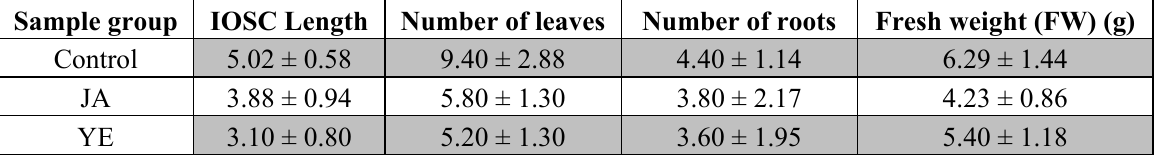
Table 1. Data of two-week IOSC behavior subjected to